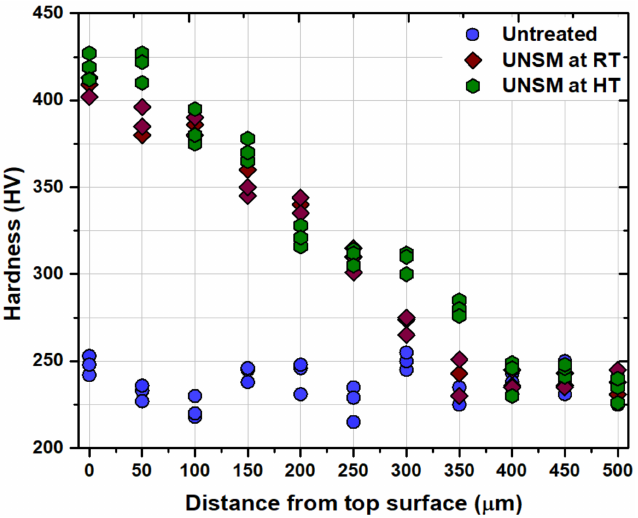
Figure 4. Hardness results of the untreated, UNSM-treated at RT and HT